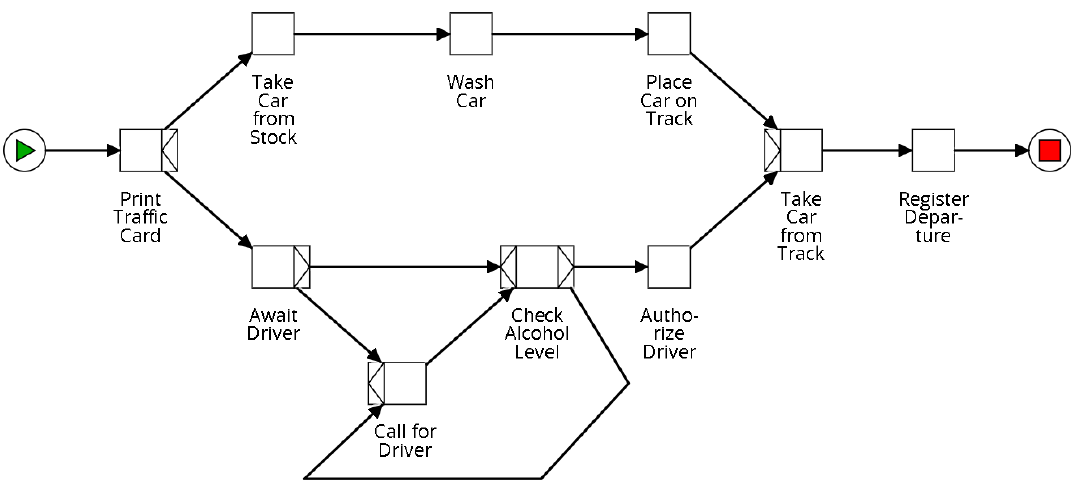
Figure 9. An example of an equivalent model to the spreadsheet-based process description presented in Table